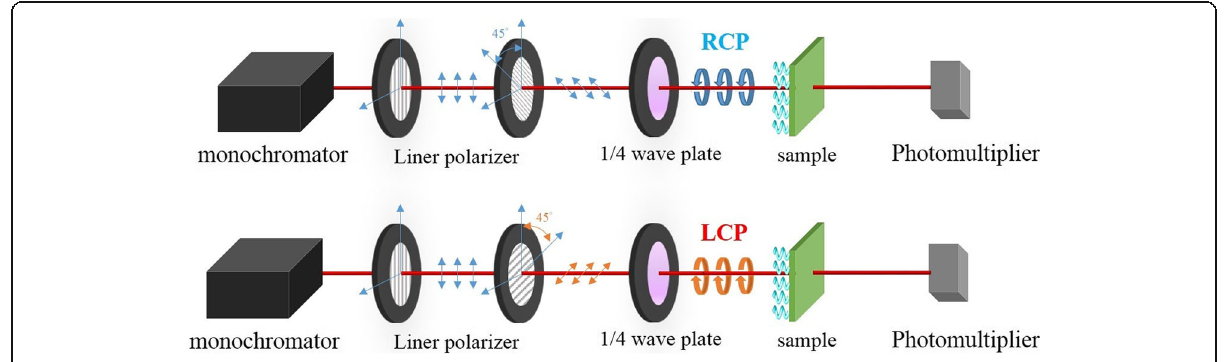
Fig. 3 Schematics of the experimental setup for optical measurements